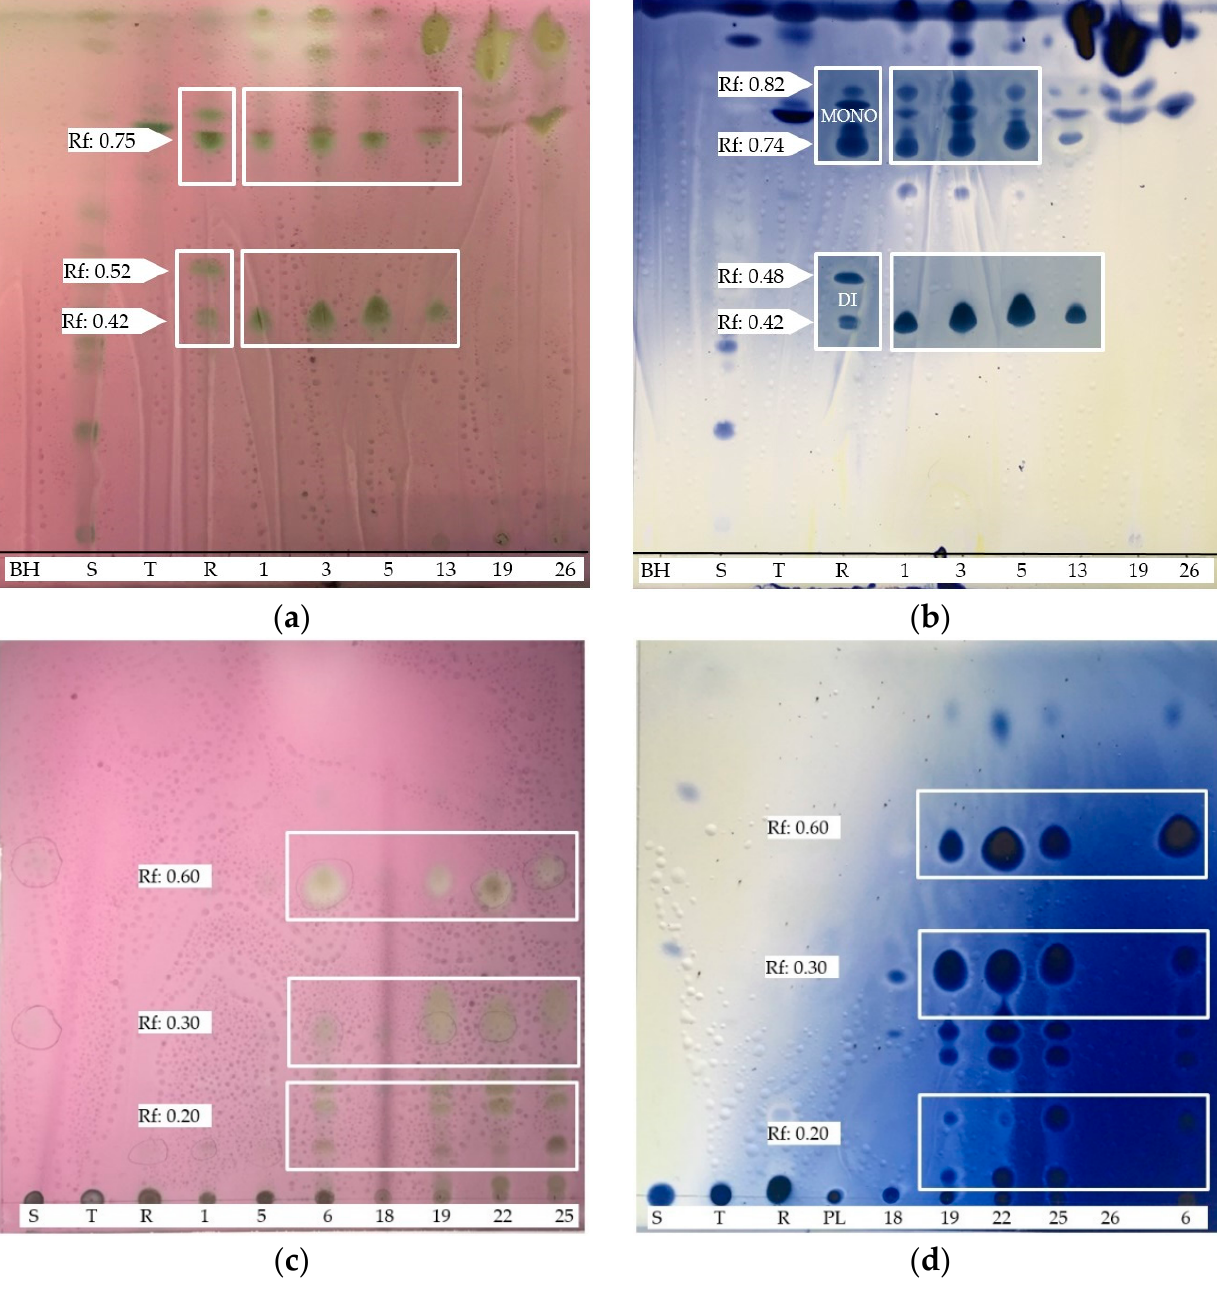
Figure 4. Examples of TLC plates of intestinal BS extracts stained for detecting sugars ( a ) and ( c ) and lipids ( b ) and ( d ). BH: Bushnell–Haas broth; S: sophorolipids; T: trealose lipids; R: rhamnolipids; PL: phospholipids; ( a ) and ( b ) = solvent system: chloroform: acetic acid:methanol:water (65:15:1:1); ( c ) and ( d ) = solvent system: chloroform:exane:ether:acetic acid (70:30:2).